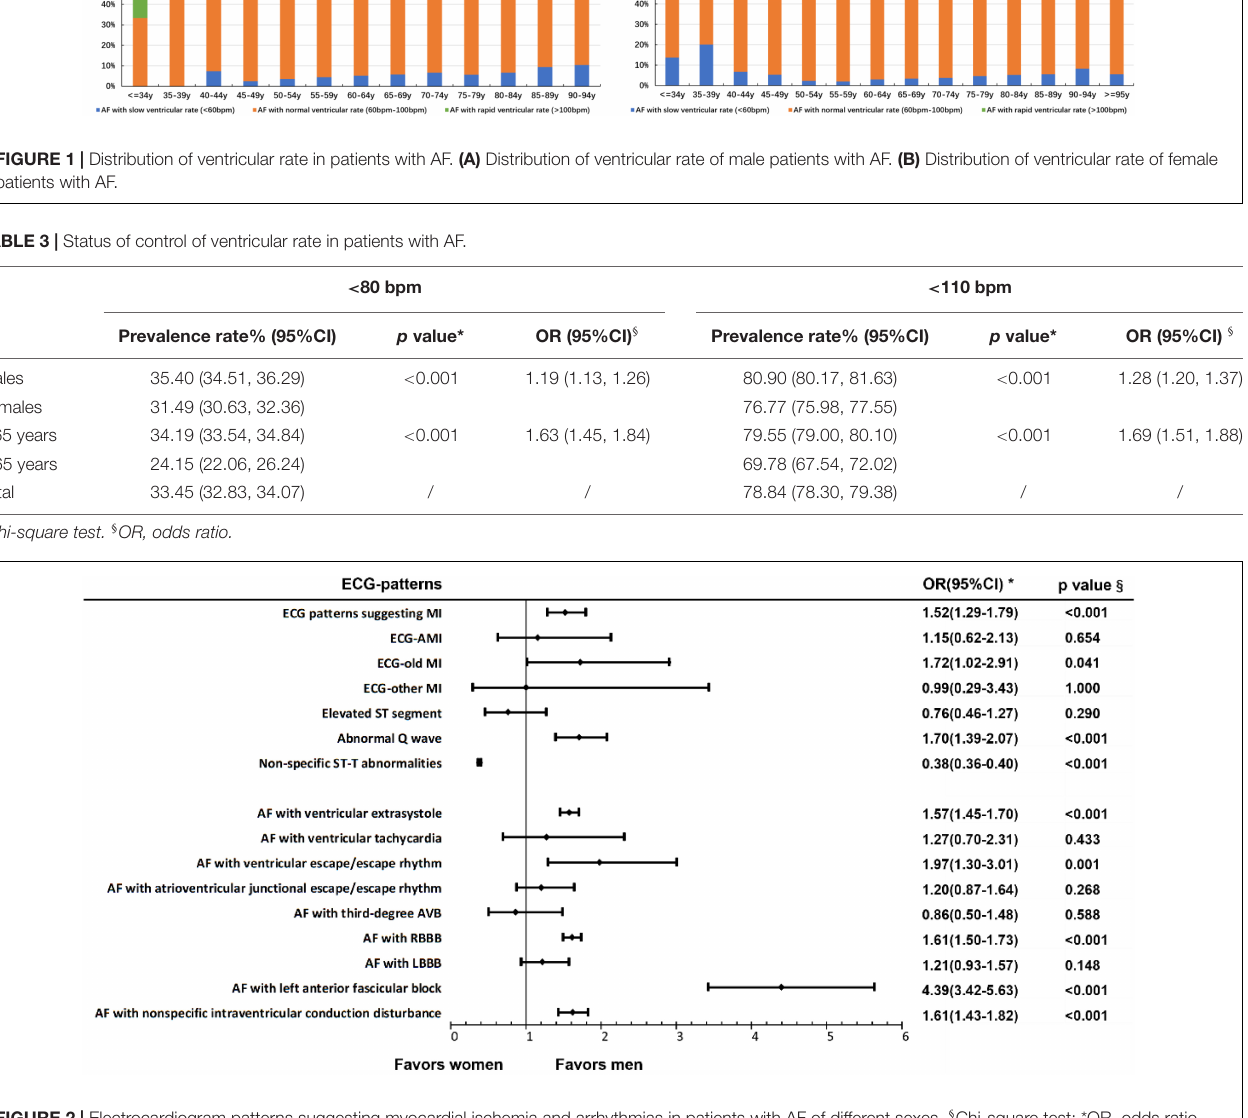
( p = 0.010). The specific results are shown in